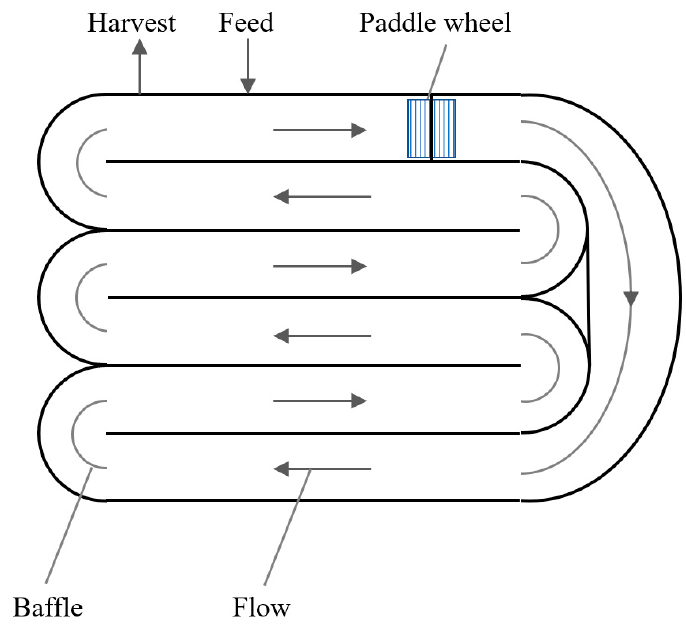
Figure 2. Scheme of a raceway pond.